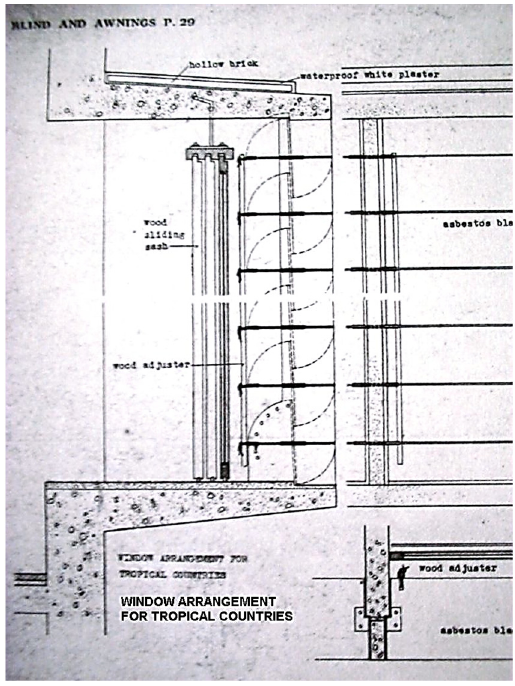
Figure 8. Detail of the pivot system for the façade, indicating the adroit solution (arrangement) devised for tropical countries and the absence of glazing to increase ventilation.